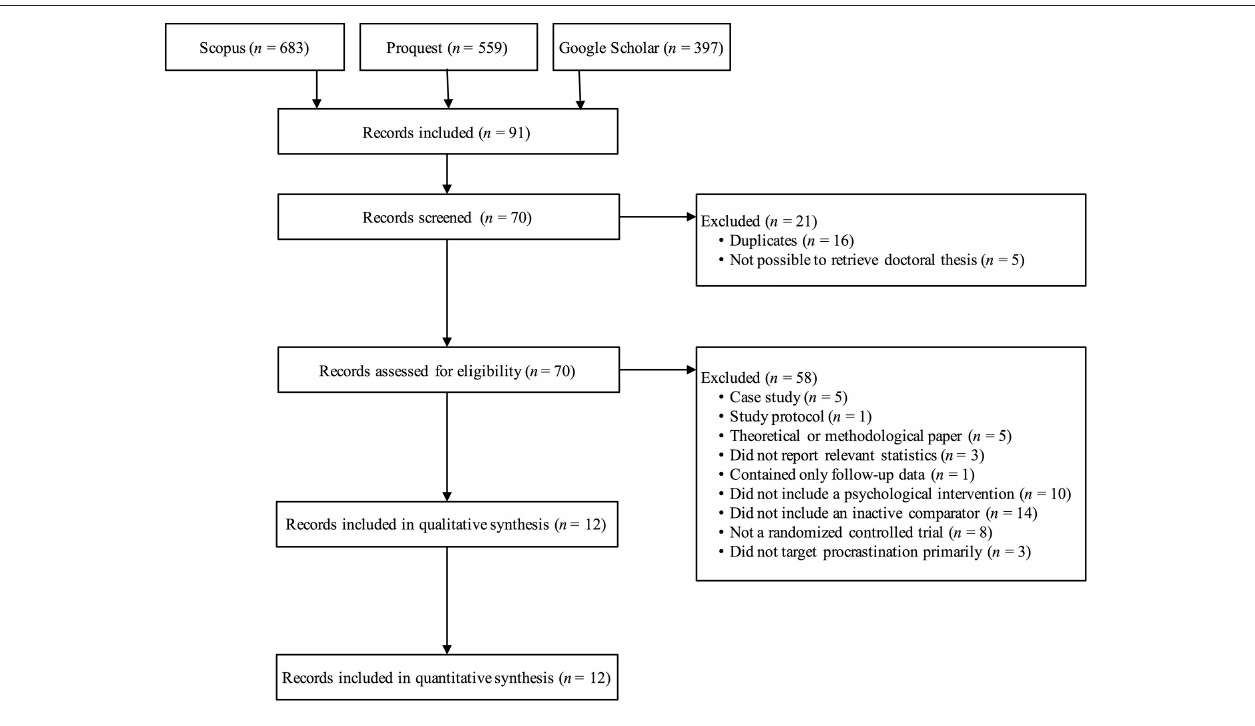
FIGURE 1 | Flow chart of study